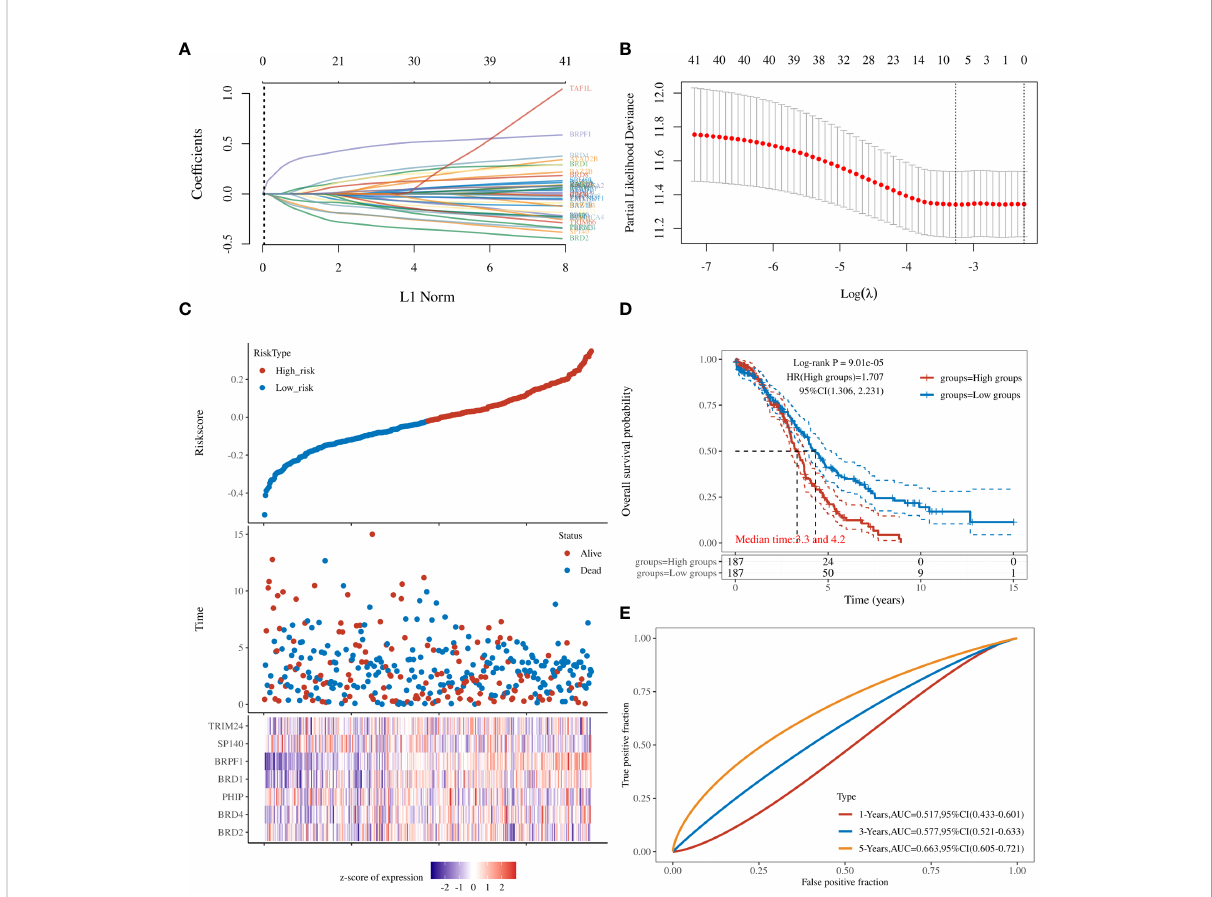
FIGURE 8 Prognostic signature of OSC patients. (A) Prognostic signature construction by LASSO Cox analysis. (B) The lambda is represented in the abscissa, and the coef fi cients are represented in the ordinate. (C) The risk score, survival time, and signature expression pro fi les in OSC patients. (D) The overall survival analysis between the high- and low-risk OSC patient groups. (E) ROC curves for survival time in OSC